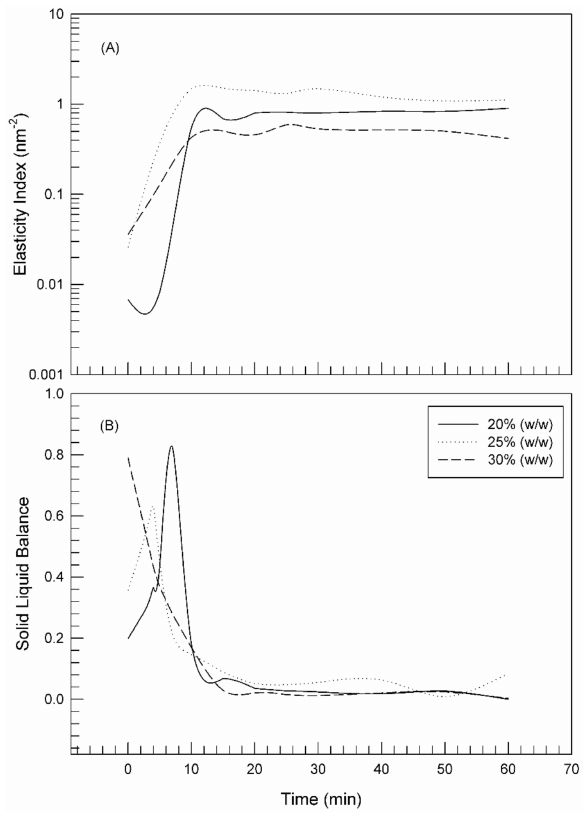
Figure 4. Elasticity Index (EI) ( A ) and Solid Liquid Balance ( B ) profiles versus time for 20% poloxamer 407, 25% poloxamer 407 and 30% poloxamer 407